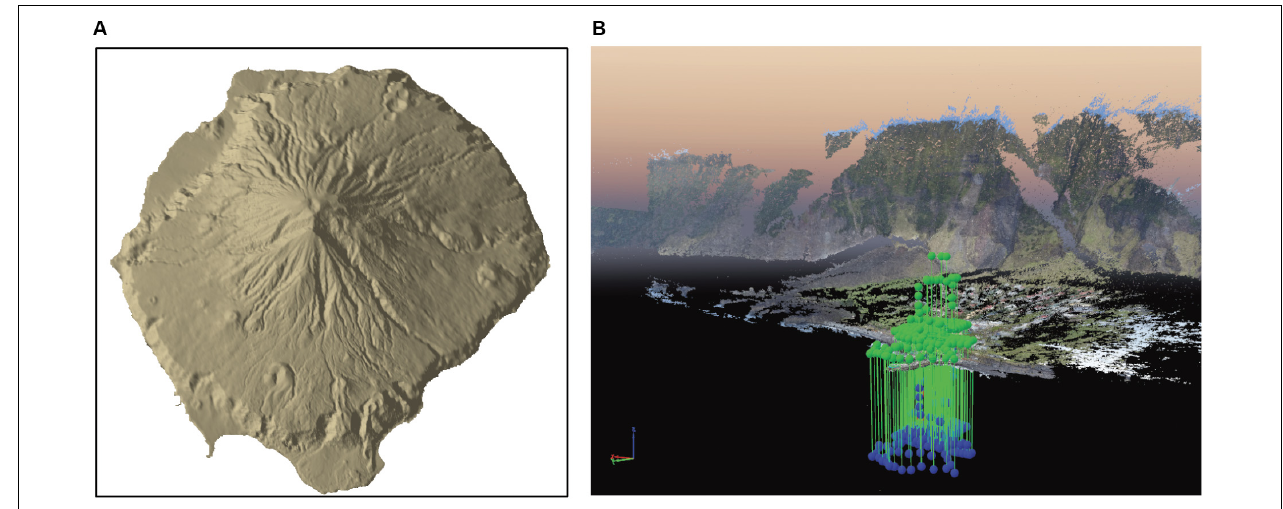
FIGURE 7 | (A) Spaceborne DEM based on WV2 imagery with 2 m resolution generated in SocetGXP. (B) Point cloud from drone photogrammetry using Pix4D with a priori camera positions (blue spheres) and after bundle block adjustment using geodetic GCPs (green